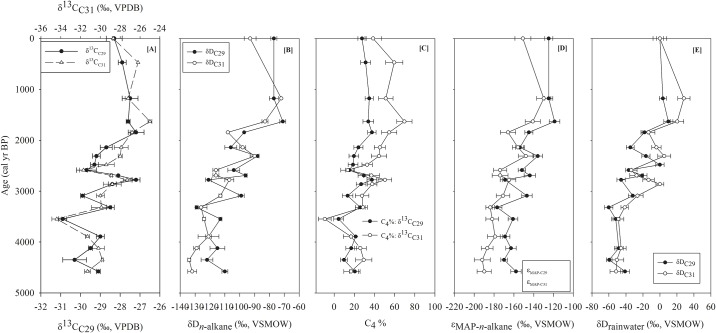
The isotopic profile and related calculations from the core sediments.[A] δ13Cn-alkane and [B] δDn-alkane values for both n-C29 and n-C31 homologues. [C] Down-core calculated fractional C4 contributions from both n-C29 and n-C31 homologues. [D] Down-core apparent hydrogen isotopic fractionation (εapp) for each homologue calculated using the measured end-member compositions and calculated fractional C4 contributions. [E] Down-core reconstructed δDrainwater values using the measured δDn-alkane and calculated εapp values for each homologue. The horizontal lines in the figure represent the error associated with the calculations.